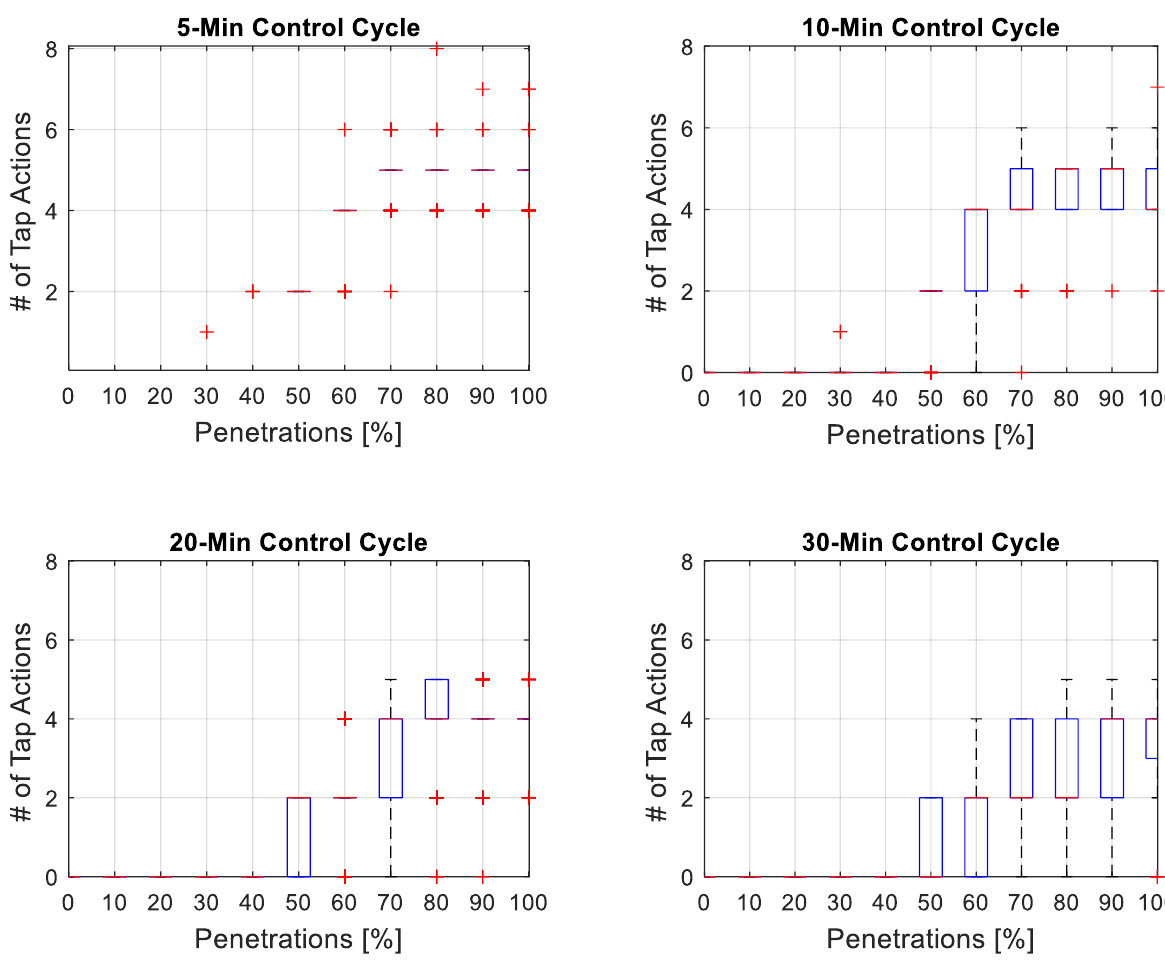
Figure 10. The number of tap actions for different control cycles using Boxplots.